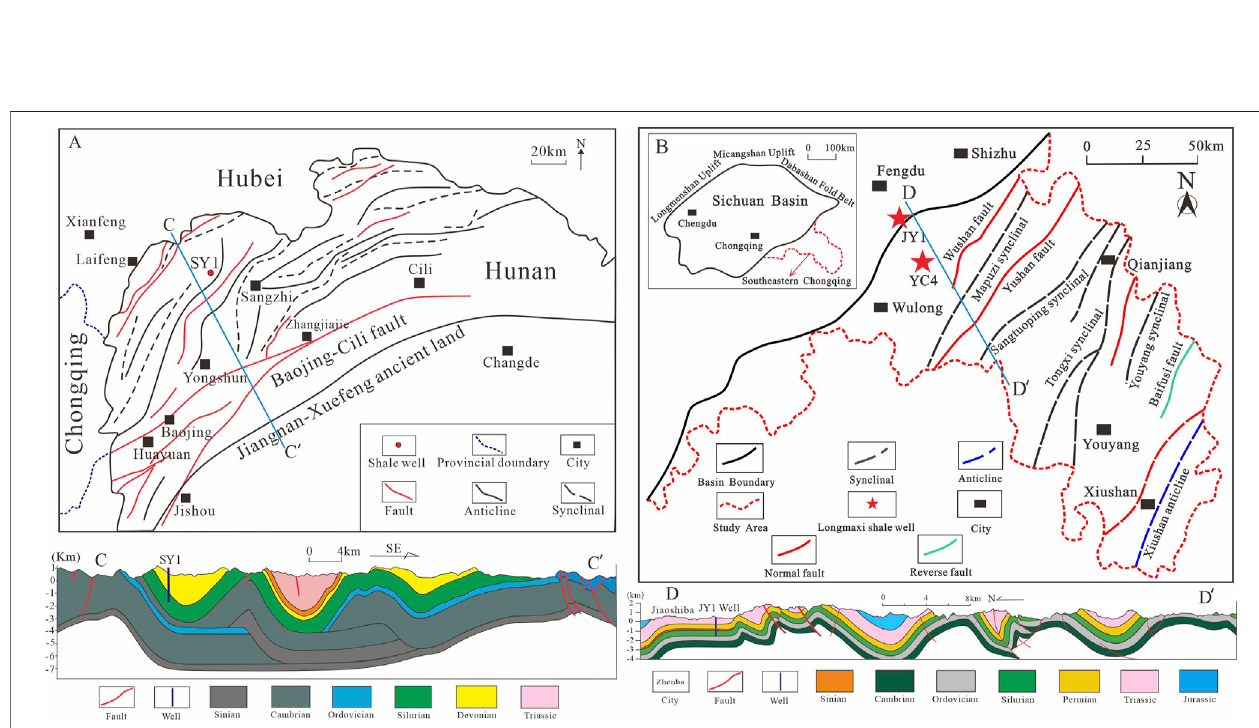
FIGURE 2 | Stratigraphic section of marine shale in south China.